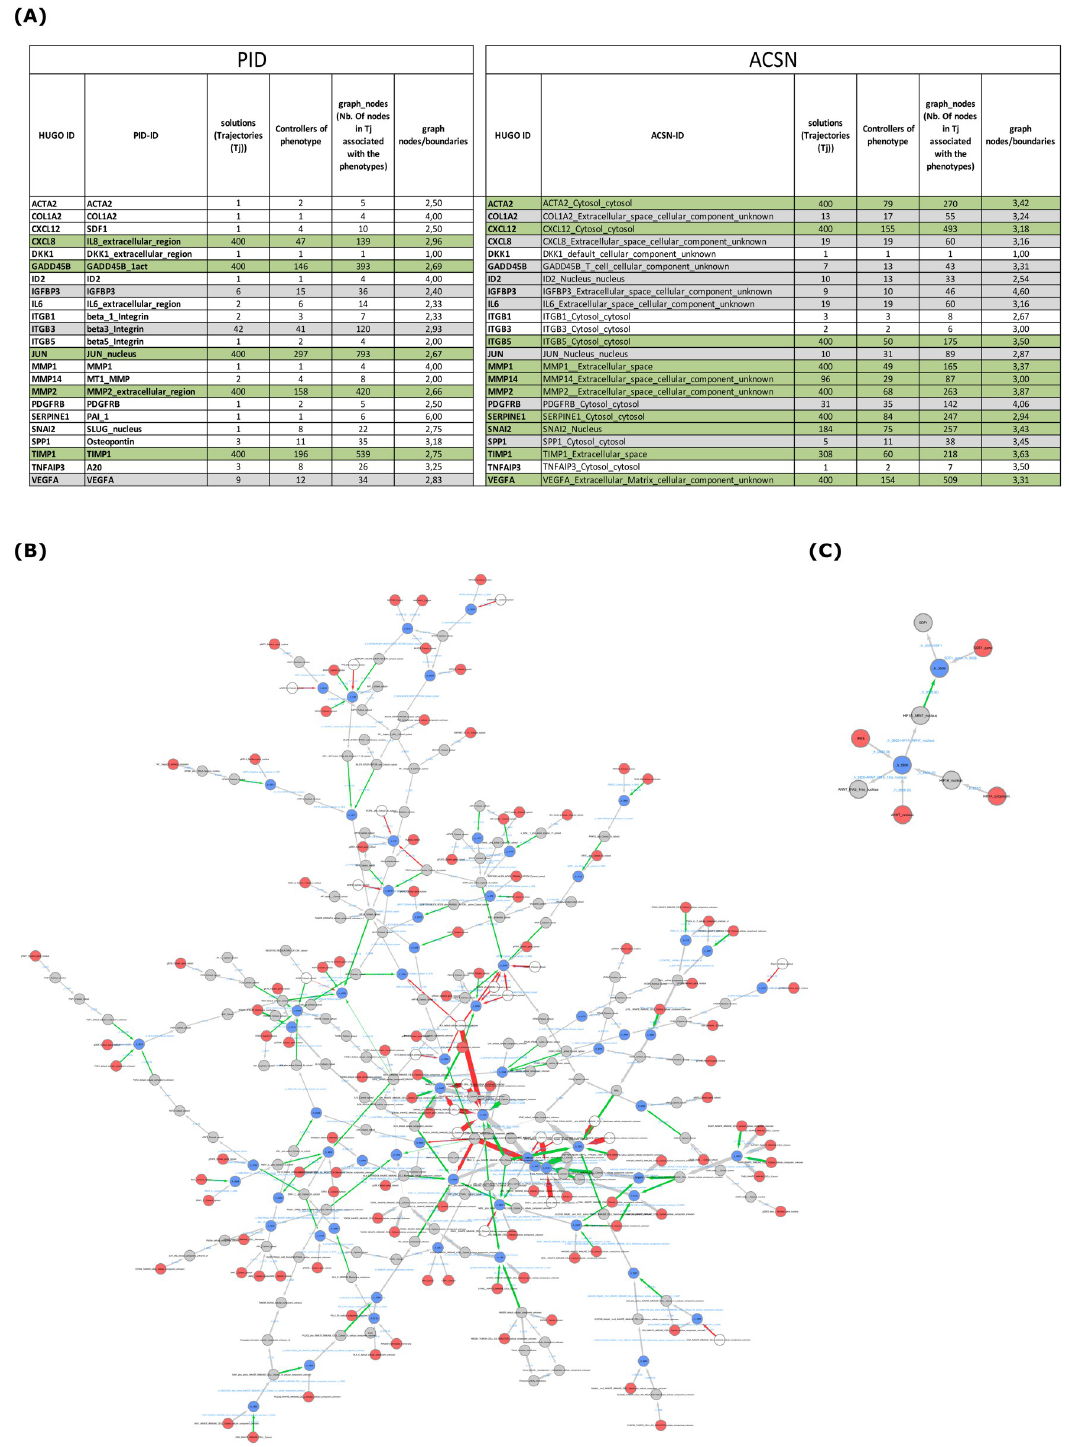
Fig 6. Comparison of EMT gene trajectories in the PID and ACSN models. (A) Analysis of 23 gene queries (phenotypes) in the PID and ACSN Cadbiom models. The first and second columns correspond to the HUGO and database identifiers, respectively. The third column describes the number of trajectories leading to the phenotype. The fourth column describes the number of controllers. The fifth column describes the number of nodes in all trajectories leading to the phenotype. The sixth column describes the ratio of the number of nodes in all trajectories to the number of controllers. Rows highlighted in green correspond to